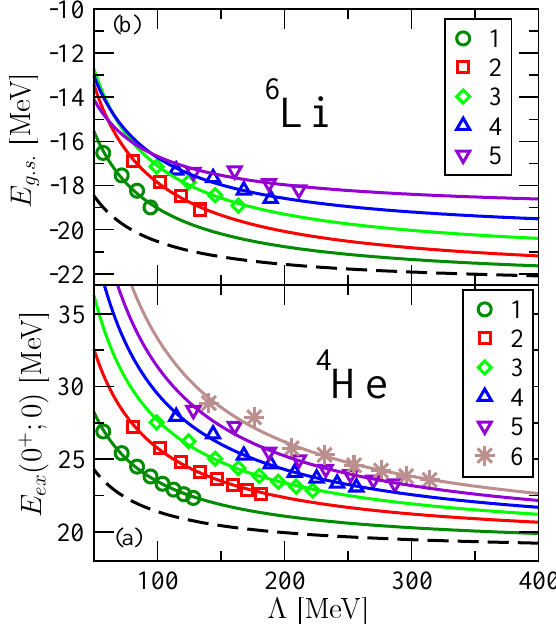
Fig. 1. Running with the ultraviolet cuto ff for two observables: the first (0 + ; 0) excited state in 4 He (lower panel) and the 6 Li ground-state energy (upper panel). The discrete points represent calculations for di ff erent frequencies, denoted in the legend in MeV, while the continuous lines represent a fit to a linear depen- dence of 1 /Λ for fixed ω . The dashed line represents the ω